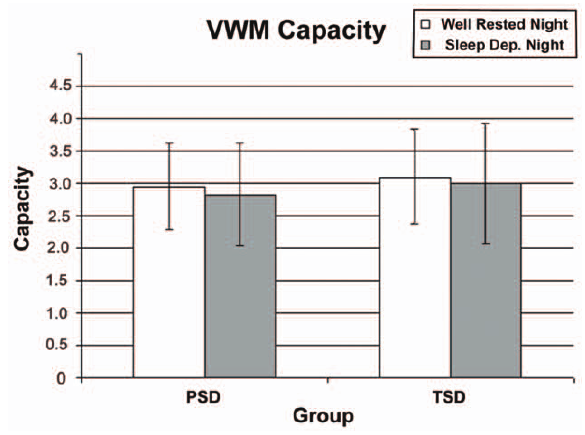
Figure 3. VWM Capacity. Values are mean 6 standard deviation.